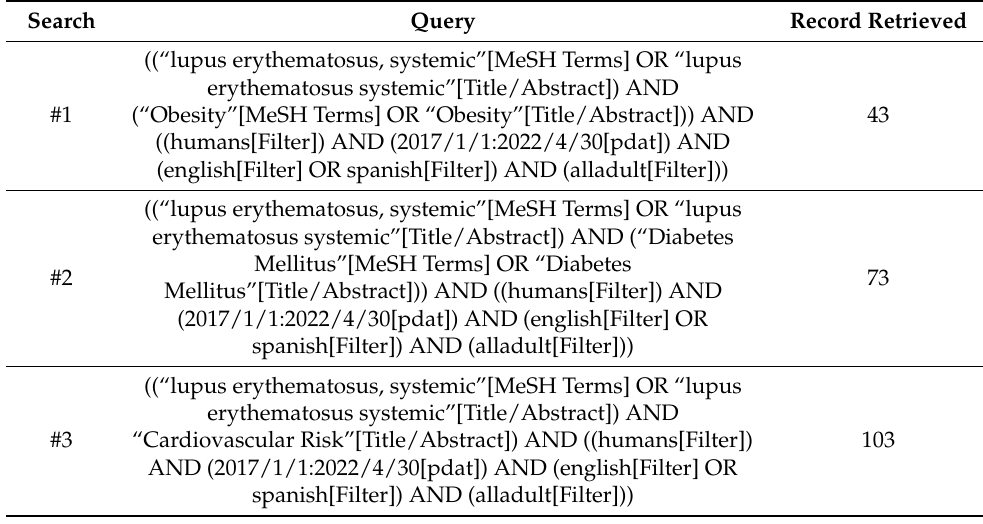
Table 1. Search strategy for MEDLINE (PubMed). The search was conducted on 3 May